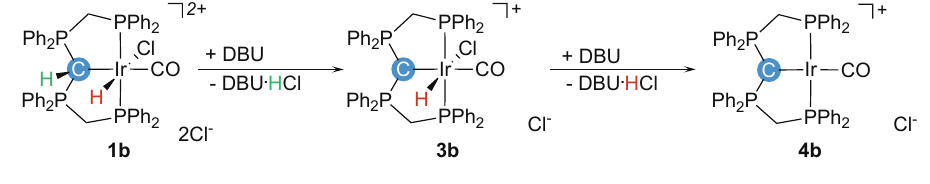
Figure 5. Reactivity of 1b towards